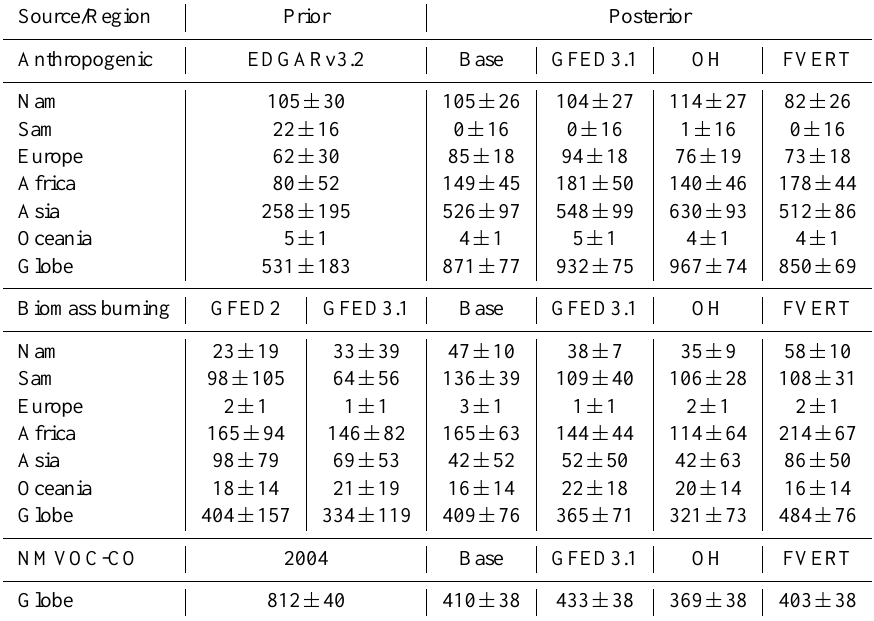
Table 4. Prior and posterior global emission estimates (in TgCOyr − 1 ) for 2004 and their uncertainty for the sensitivity studies. The first column shows the sources/regions. Columns 2 and 3 show the prior (only different for biomass burning in GFED3.1 study). The last 4 columns show the posterior emission estimates for the sensitivity studies. The results for the Base inversion (cycle 2) are included for